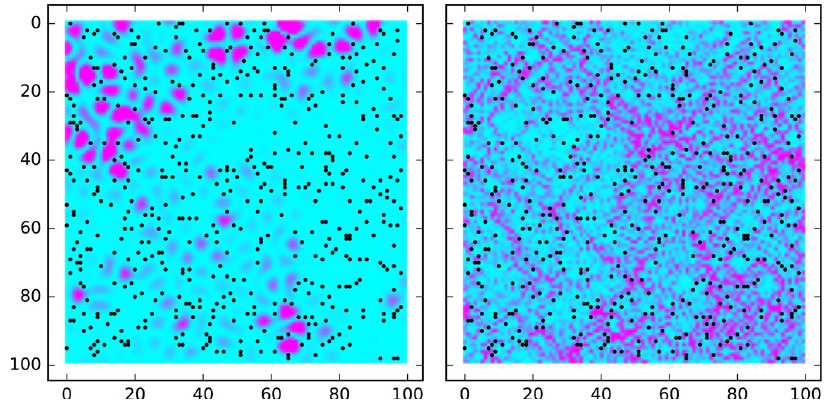
Figure 1. The intensity of the phonon wavefunctions ∝ h 2 for 5% of the pinned sites at E = 0.5 (left) and E = 3.1 (right). Pinned sites are indicated as dots.